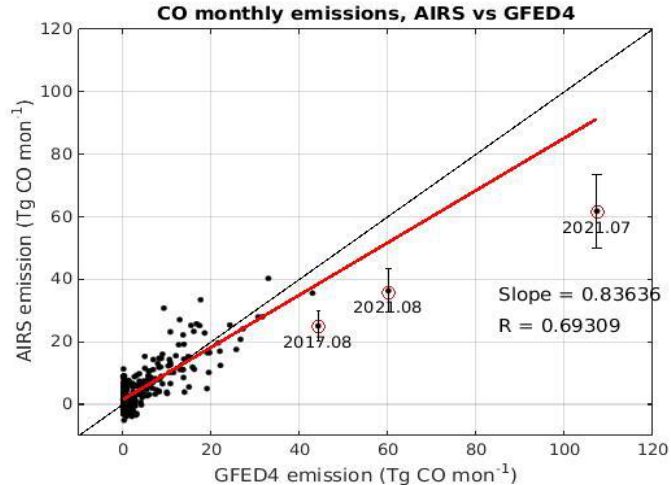
Figure 5. Monthly CO emitted by fires in HNH according to AIRS in comparison with GFED4c data [3]. Times for most scattered points are labeled. Error bars ± 19% here and in Figure 6 correspond to the accuracy of the correction for reduced sensitivity term.